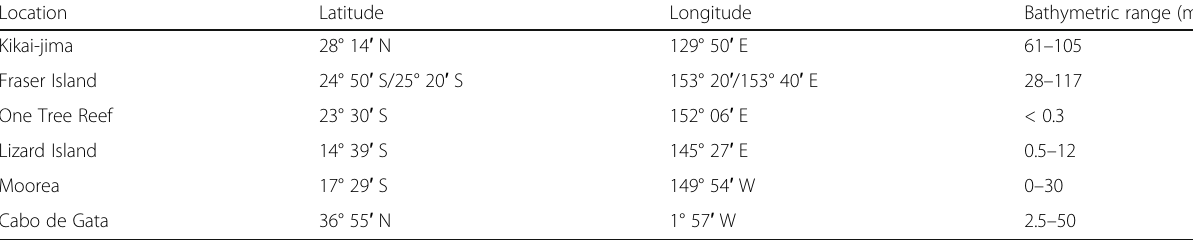
Table 1 Geographic co-ordinates and bathymetric ranges of the sampled areas Location